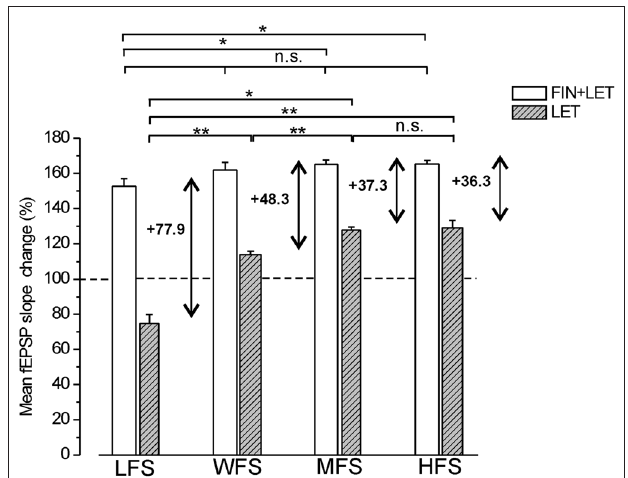
FIGURE 7 | Schematic draw showing the different influence of neo-synthesized DHT and E2 on the LFS-LTD and HFS-LTP. (A) LTD is induced in the presence of basal DHT synthesized by 5 α -reductase enzyme from T (thin up arrow) and/or DHT synthesized by LFS (dashed arrow, thick up arrow). DHT exerts an inhibitory effect reverting the basal partial LTP (pLTP) into LTD. Synthesis of E2 is not involved in the LFS-LTD. but the exogenous E2 can enhance the pLTP to a full LTP. (B) pLTP is changed into a full LTP in the presence of basal E2 synthesized from T by P450-aromatase (thin up arrow) and/or E2 synthesized by HFS (dashed arrow, thick up arrow). The minor inhibitory effect of DHT on pLTP (thin arrow) might be prevented by an inhibitory influence of E2 on DHT (dotted